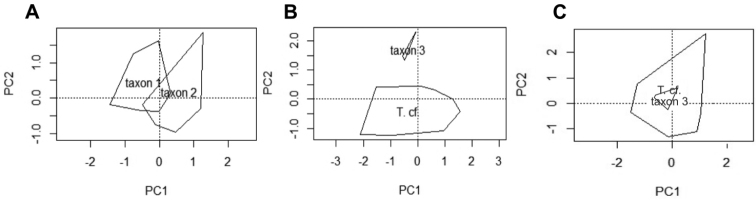
Scatterplot between PC1 and PC2 of the morphological characters corrected to SVL and log–transformed, for A taxon 1 and taxon 2 of the Vietnamese Tylototriton
cf.
asperrimusB the head- and dorso- related data of taxon 3 from Lai Chau Province and T.
cf.
asperrimus from Vietnam sensu lato; and C the limb related data of taxon 3 from Lai Chau Province and T.
cf.
asperrimus from Vietnam sensu lato. In the graphics T. cf. refers to T.
cf.
asperrimus.